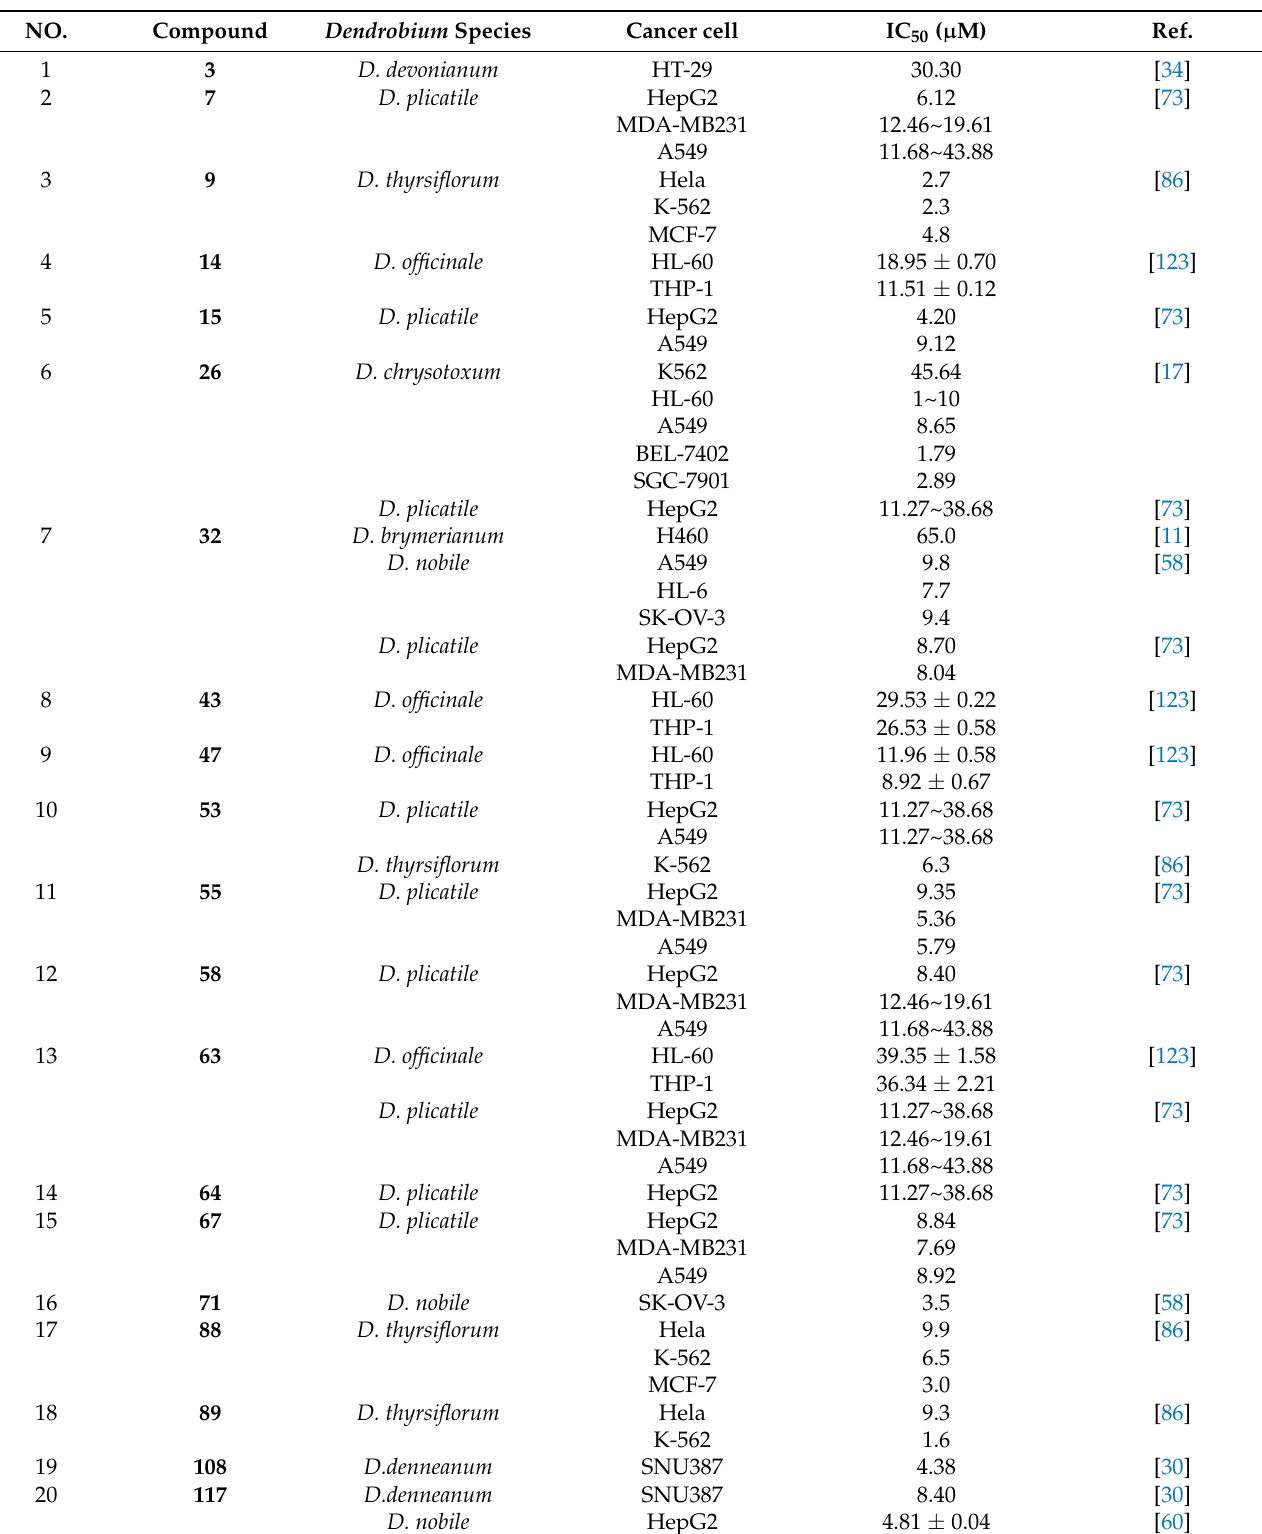
Table 7. The IC 50 of stilbenes inhibiting cancer cells (IC 50 µ